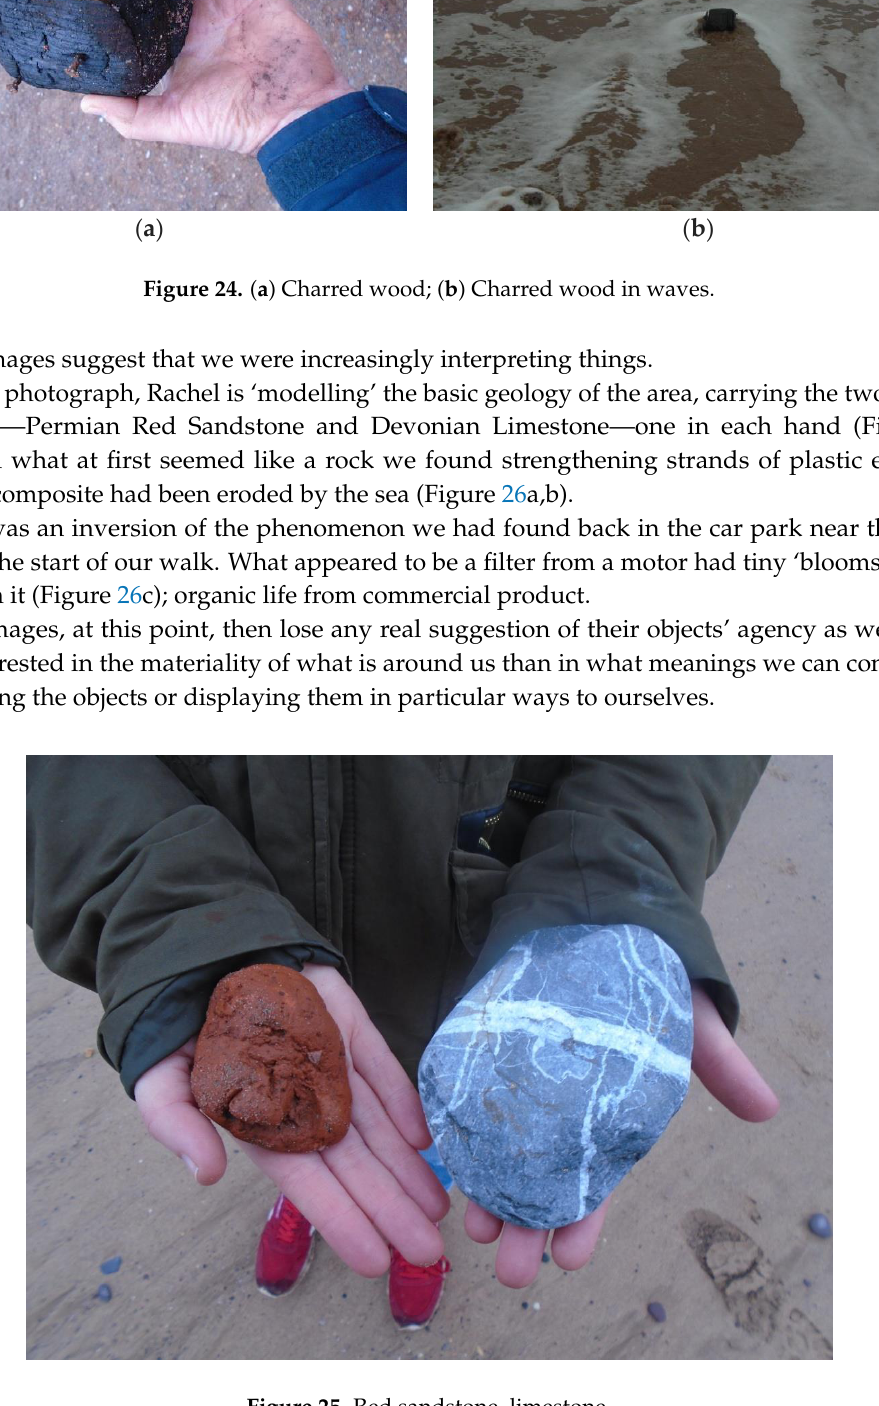
Figure 25. Red sandstone, limestone.